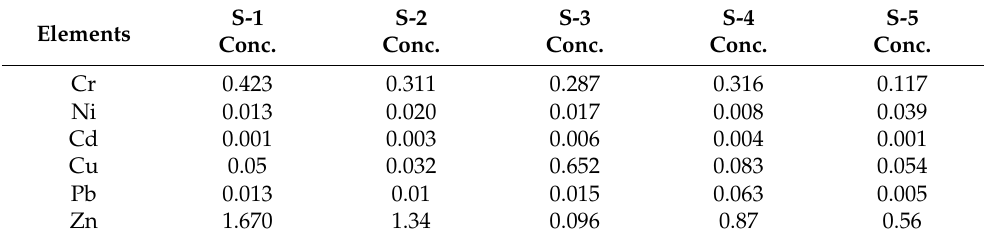
Table 1. The concentration (mg/L) of identified metallic ions present in the effluents.